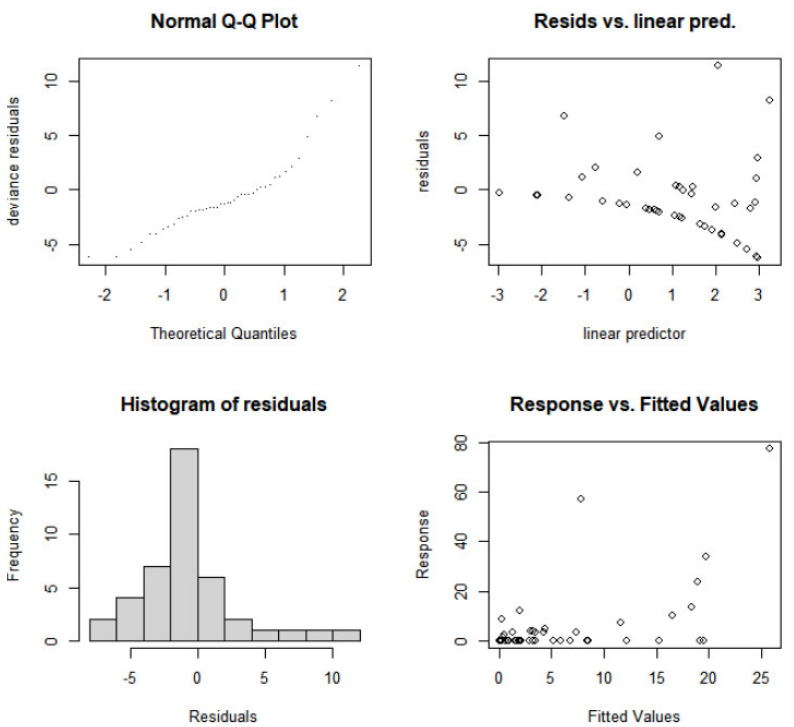
Figure A3. Density function modelling individuals per segment as a function of NDVI using a log-link quasi-Poisson model. The model was fitted using the restricted maximum likelihood (REML). Displayed above are diagnostic plots for the selected model using the function ‘gam.check’ in the package